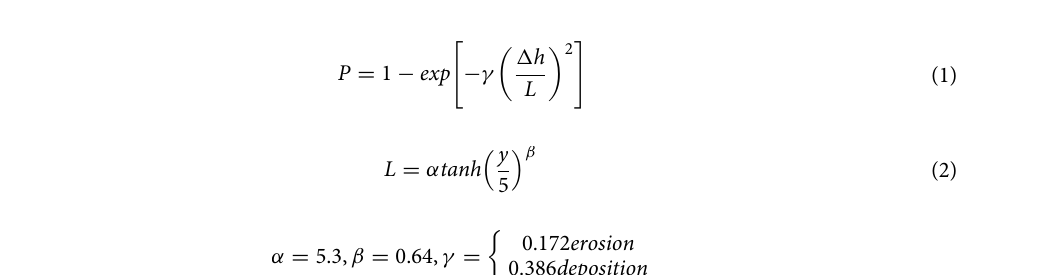
Figure 3. ( a ) Shell length of local clams at different growth phases evaluated by measured data and Eq. (2); ( b ) Expected loss probability based on experimental data and Eqs. (1–2) for abrupt change in sediment layer